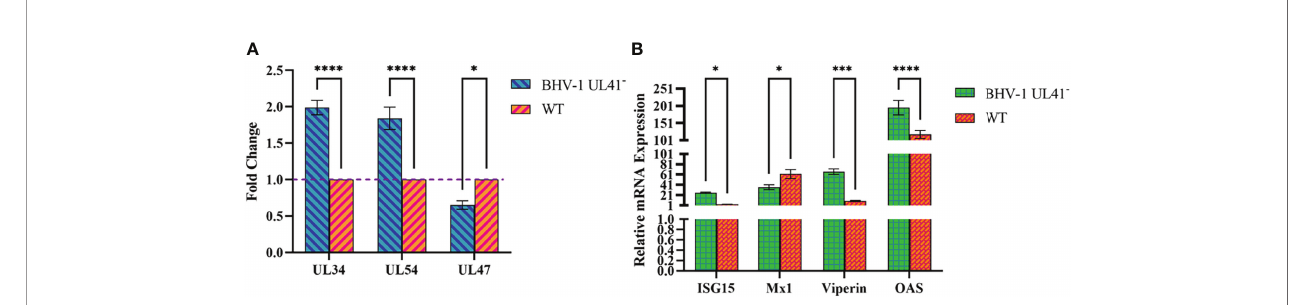
FIGURE 5 | BHV-1 UL41 − regulates viral and host mRNAs. (A) BHV-1 UL41 regulates viral mRNA. The BHV-1 UL41 - and WT strains were used to infect MDBK cells at an MOI of 1, and total RNA was collected at 12 hpi. The mRNA levels of the immediate early gene UL34, the early gene UL54, and the late gene UL47 were analyzed using reverse transcription qPCR and normalized to those of 18S rRNA. The data are plotted as the fold change over the WT strain. (B) BHV-1 UL41 regulates host mRNA. The BHV-1 UL41 − and WT strains were used to infect MDBK at an MOI of 1, and total RNAs RNA was collected at 8 hpi. The relative gene expression levels were determined with the 2 − DD CT method. The viral titers were detected in three independent experiments and calculated as the mean ± SD. **** for p < 0.0001, *** for p < 0.001, and * for p